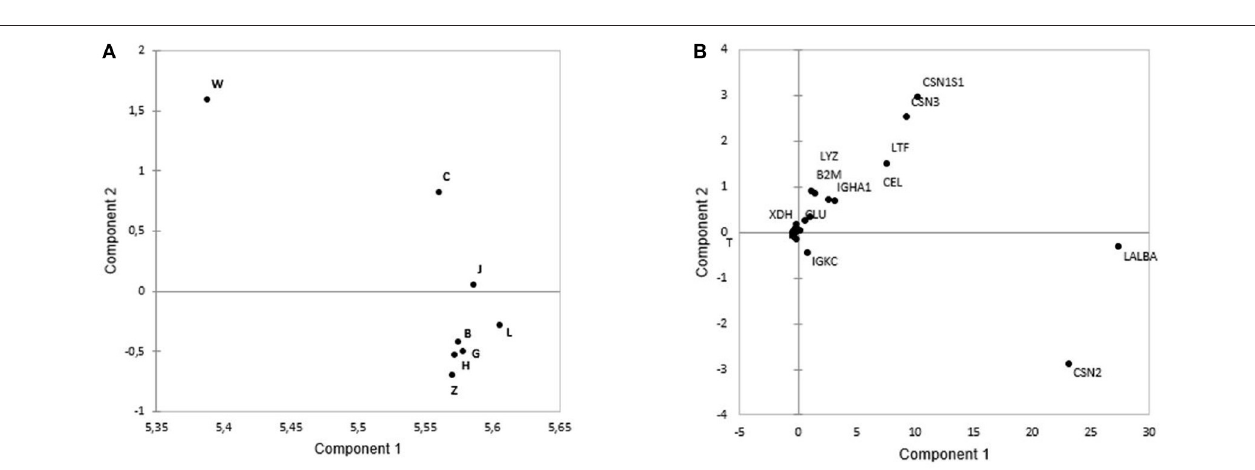
FIGURE 1 | Major gene ontology (GO) biological process of overall identified proteins in Chinese human milk (HM) enriched by the DAVID bioinformatics.